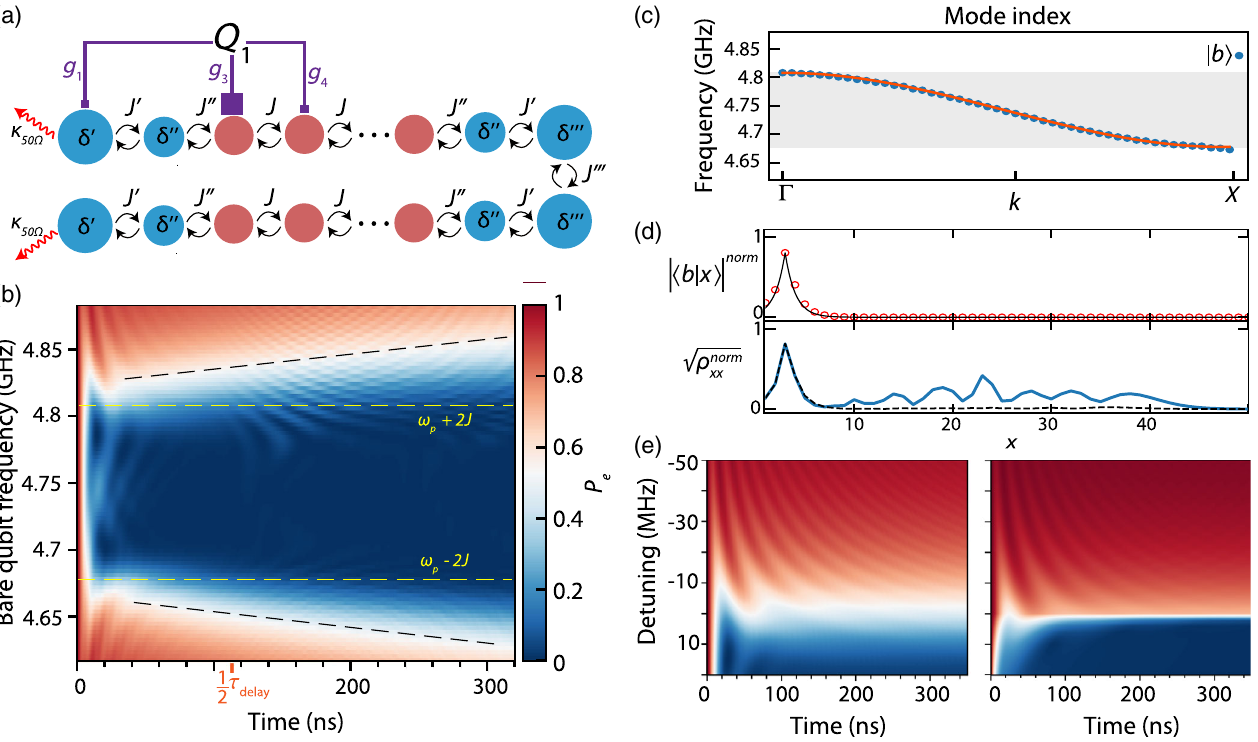
FIG. 9. Master equation numerical simulations of our qubit – slow-light waveguide system. (a) Diagram of tight-binding model used in simulations. Simulation parameters are described in the text. Note that the next-nearest-neighbor coupling J , which is present in the nnn model for all resonators, is omitted from the diagram for readability purposes. (b) Simulation of Fig. 3(b) dataset. Band edges are highlighted in dashed yellow lines, while dashed black lines are guides to the eye. (c) Scatter plot of the eigenenergies of the Hamiltonian = ð 2 π Þ ¼ 83 MHz (in the single-excitation manifold) offset by ω in Eq. (E2) with Δ . The orange curve is a plot of the dispersion ge p relation [see Eq. (B7)]. The eigenmode with energy outside of the passband corresponds to the bound state of the system j b i . (d) Plot of photonic states of the system as a function of position x . Top: plot of the photonic wave function of the bound eigenstate of the system ffiffiffiffiffiffiffiffiffiffiffiffiffiffiffiffiffiffiffiffiffiffiffiP p , where j x i j b i in open red dots; “ norm ” indicates that the photonic wave function coefficients h x j b i are normalized by jh x j b ij 2 ffiffiffiffiffiffiffiffiffiffiffiffiffiffiffiffiffiffiffiffiffiffiffiffiffi p x ; g i . The solid black line corresponds to a plot of Ae j x − 3 j = λ , where λ ¼ − ω ; … ; 0 J= ð E corresponds to the state j 0 1 ; 0 2 ; … ; 1 and 0 Þ x M b A is a normalization constant. Bottom: plot of the photonic portion of the simulated qubit-waveguide state after t ¼ 90 ns. The solid blue ; e i ; the dashed black line corresponds to a simulation with initial state line corresponds to a simulation with initial state j 0 1 ; 0 2 ; … ; 0 P M 10 ρ . This particular scaling is chosen because it similarly scales the j b i . ρ norm xx refers to the scaled density matrix element ρ xx = ð xx Þ x ¼ 1 photonic part of the state within the first ten resonators of the array, thereby aiding visual comparison between the blue and dashed black curves. (e) Comparison of the dynamics simulated by a modified tight-binding model of a qubit coupled to a metamaterial waveguide (left) and by population equations of motion derived in Ref. [11] (right). Refer to (b) for the color bar. Both models assume g = 2 π ¼ 19 MHz, as well as J= 2 π ¼ 33 MHz. See the text for a description of the modified model. We use ð g 4 = 4 J Þ 1 = 3 in place of β for uc uc simulations using Eqs. (2.21) – (2.28) from Ref.